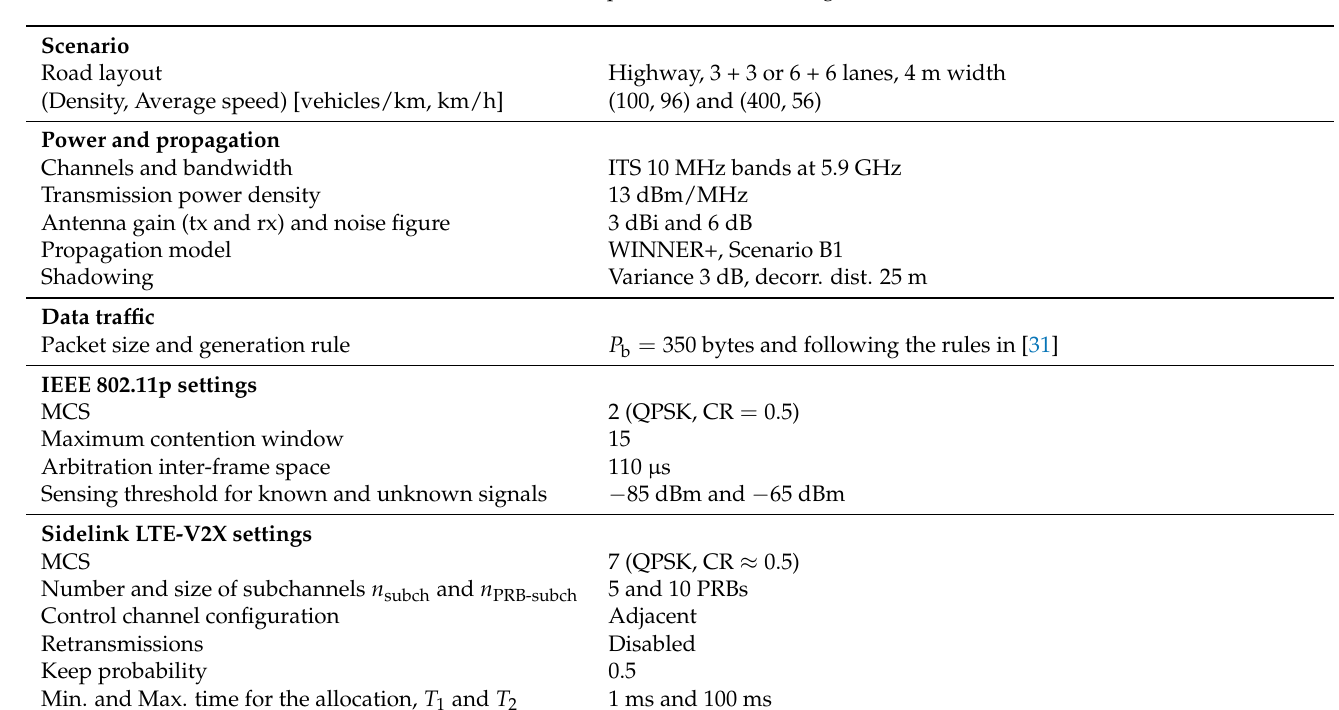
Table 1. Main simulation parameters and